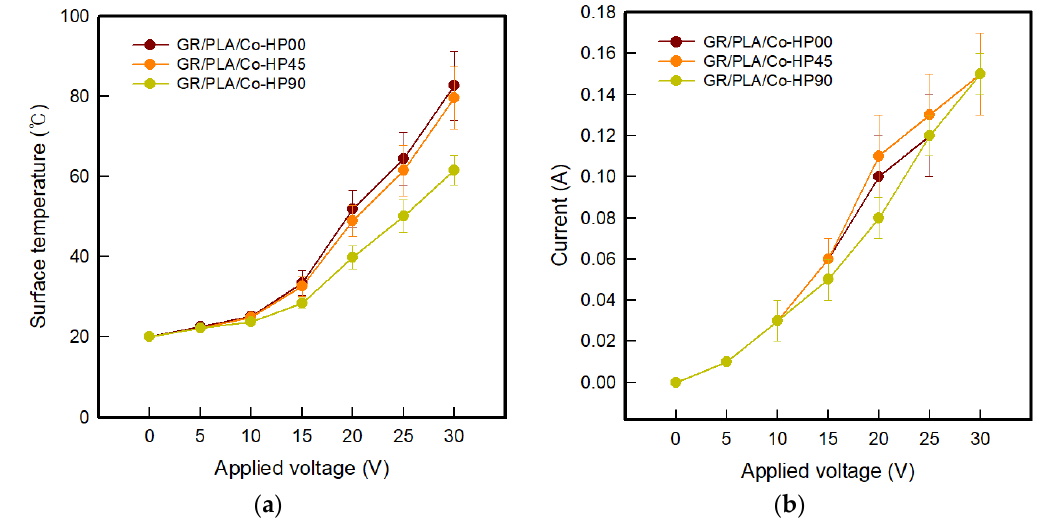
Figure 7. ( a ) Surface temperature-voltage and ( b ) current–voltage of CFDM 3D-printed horseshoe pattern cotton fabric with different 3D printing directions.